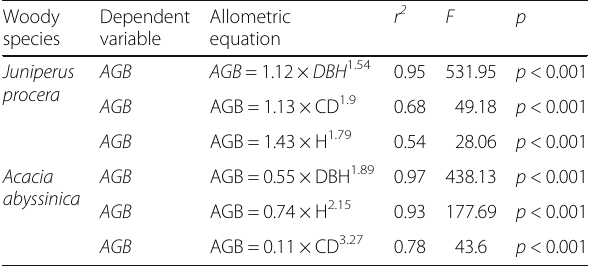
Table 2 Allometric functions of the best fits for the different tree dendrometric variables: Diameter at breast height (DBH), height (H), crown diameter (CD) and total above ground dry biomass (AGB) in the Gergera watershed, Ethiopia Woody